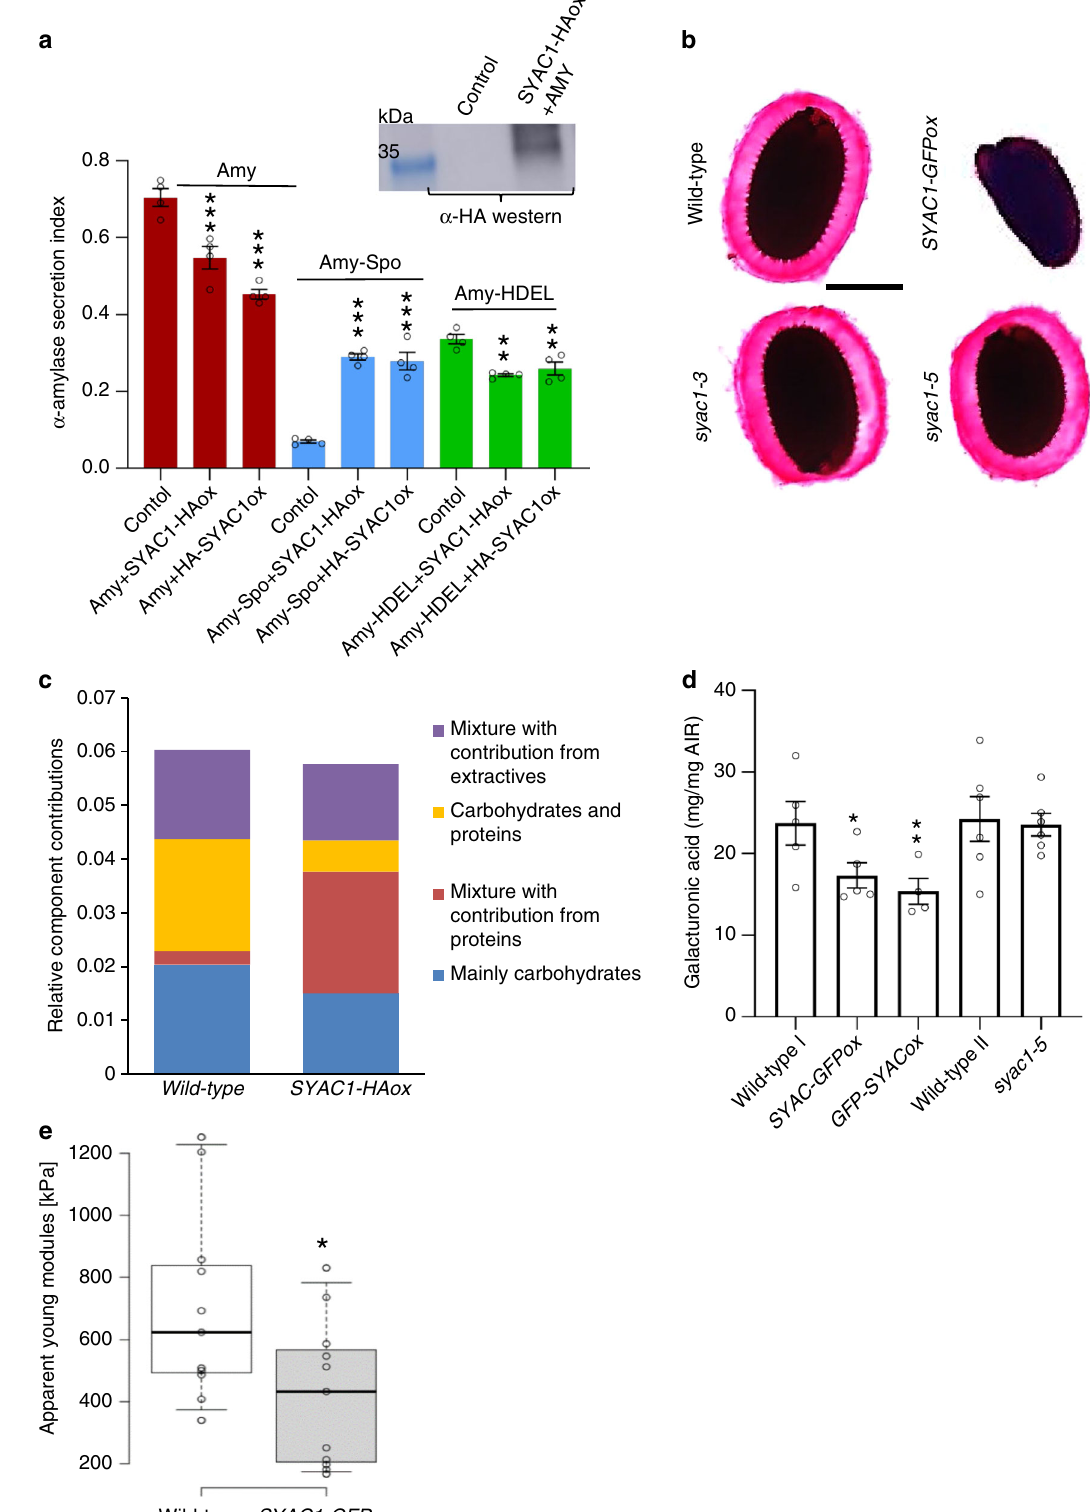
SYAC1 fi ne tunes the cell wall composition and mechanics . In plants, new cell wall components such as pectins and hemicellulose are proposed to be delivered to the extracellular matrix via the secretory pathway 38 . SYAC1 reduction of α -Amylase secretion, along with its Golgi/TGN/endosomal localization and interaction